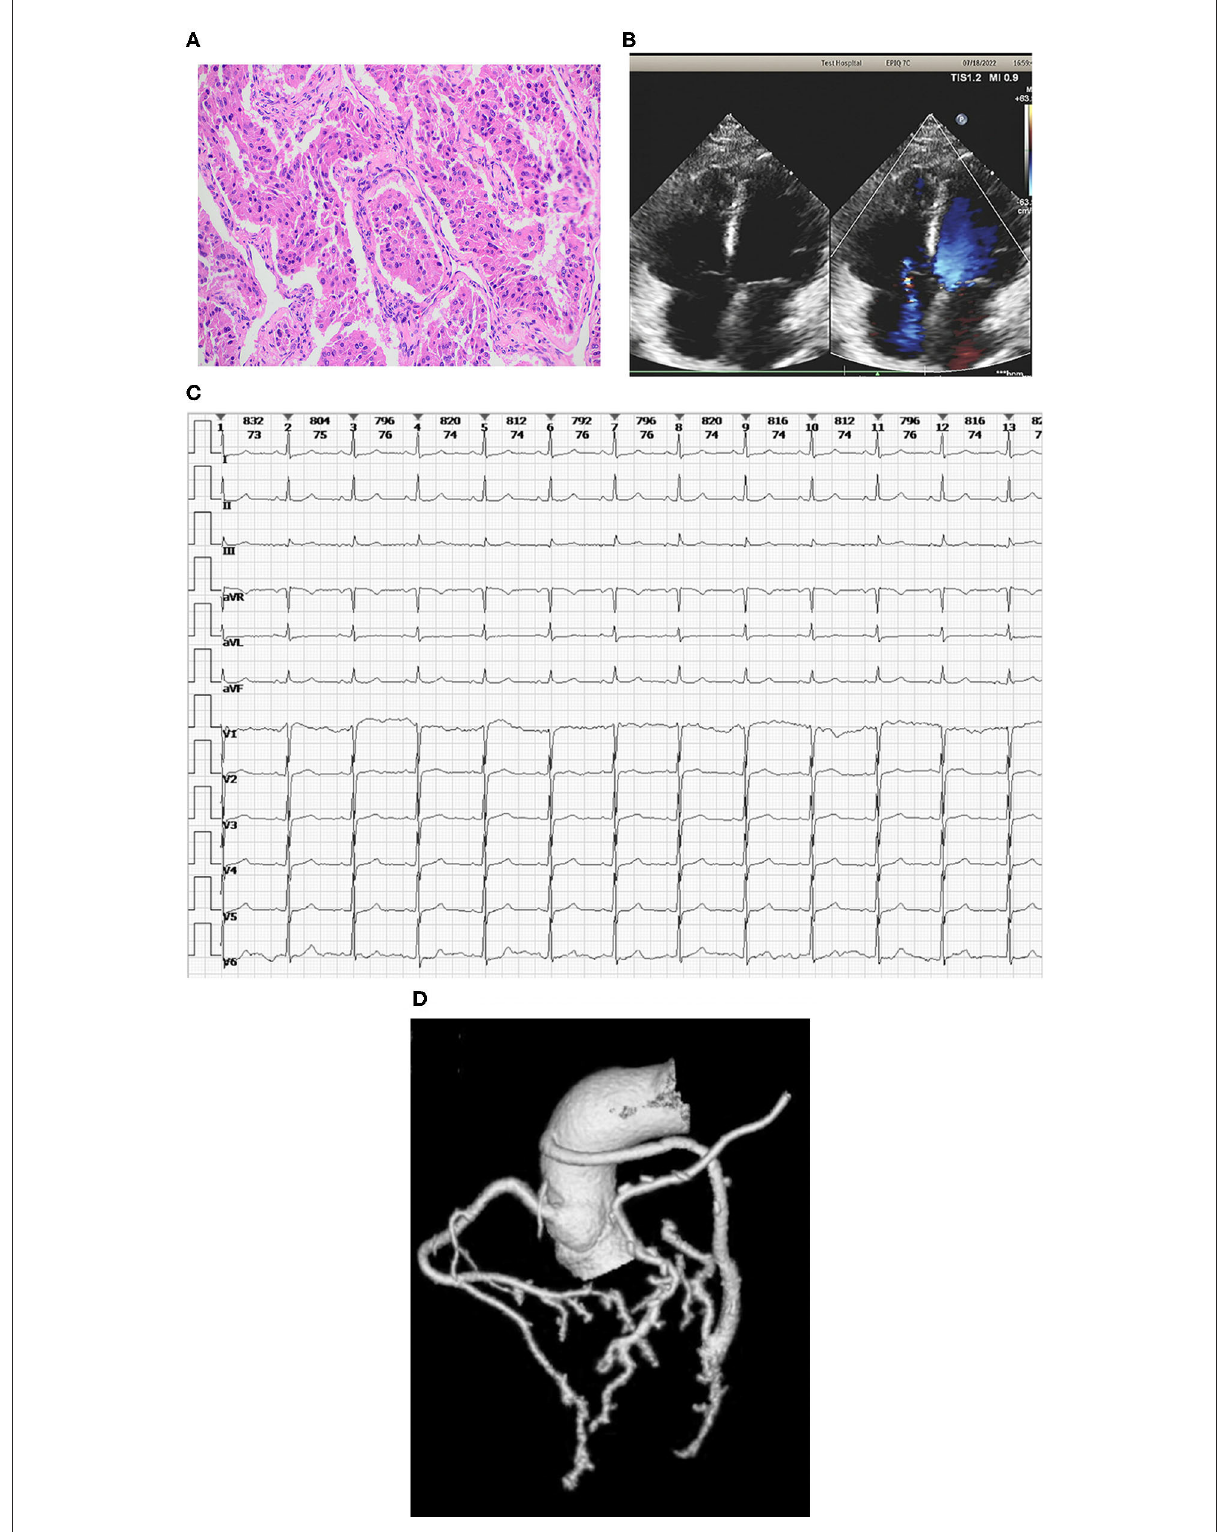
FIGURE2 (A) Pathology of the removed mass. The pathological findings of the mass were confirmed as cardiac paraganglioma. (B) The echocardiography at the latest follow-up. Morphologically, all the chambers and valves were normal and the heart function was stable without any serious abnormal changes. (C) Sinus rhythm in electrocardiogram rechecking. (D) Coronary CT angiography shows a patent coronary